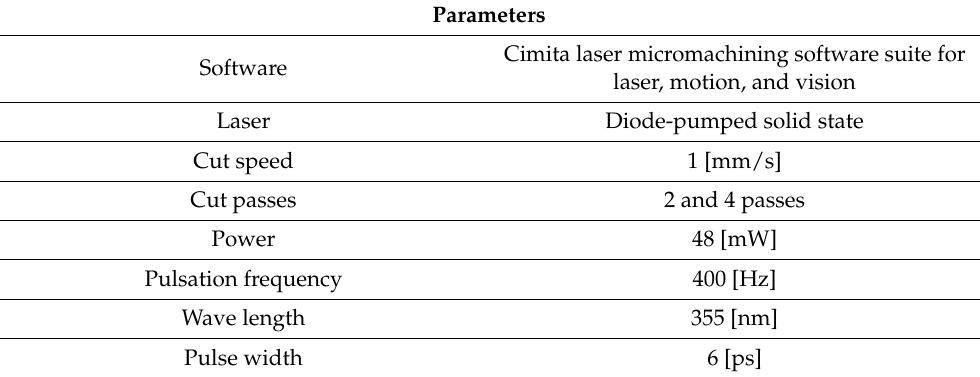
Table 2 . LST system parameters . Table 2. LST system